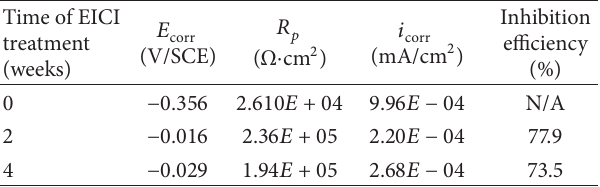
Table 4: 𝐸 corr , 𝑅 𝑝 , and 𝑖 corr values obtained from the weak polariza- tion tests for contaminated samples (0.5% chloride) with or without EICI treatment in sodium hydroxide solution.